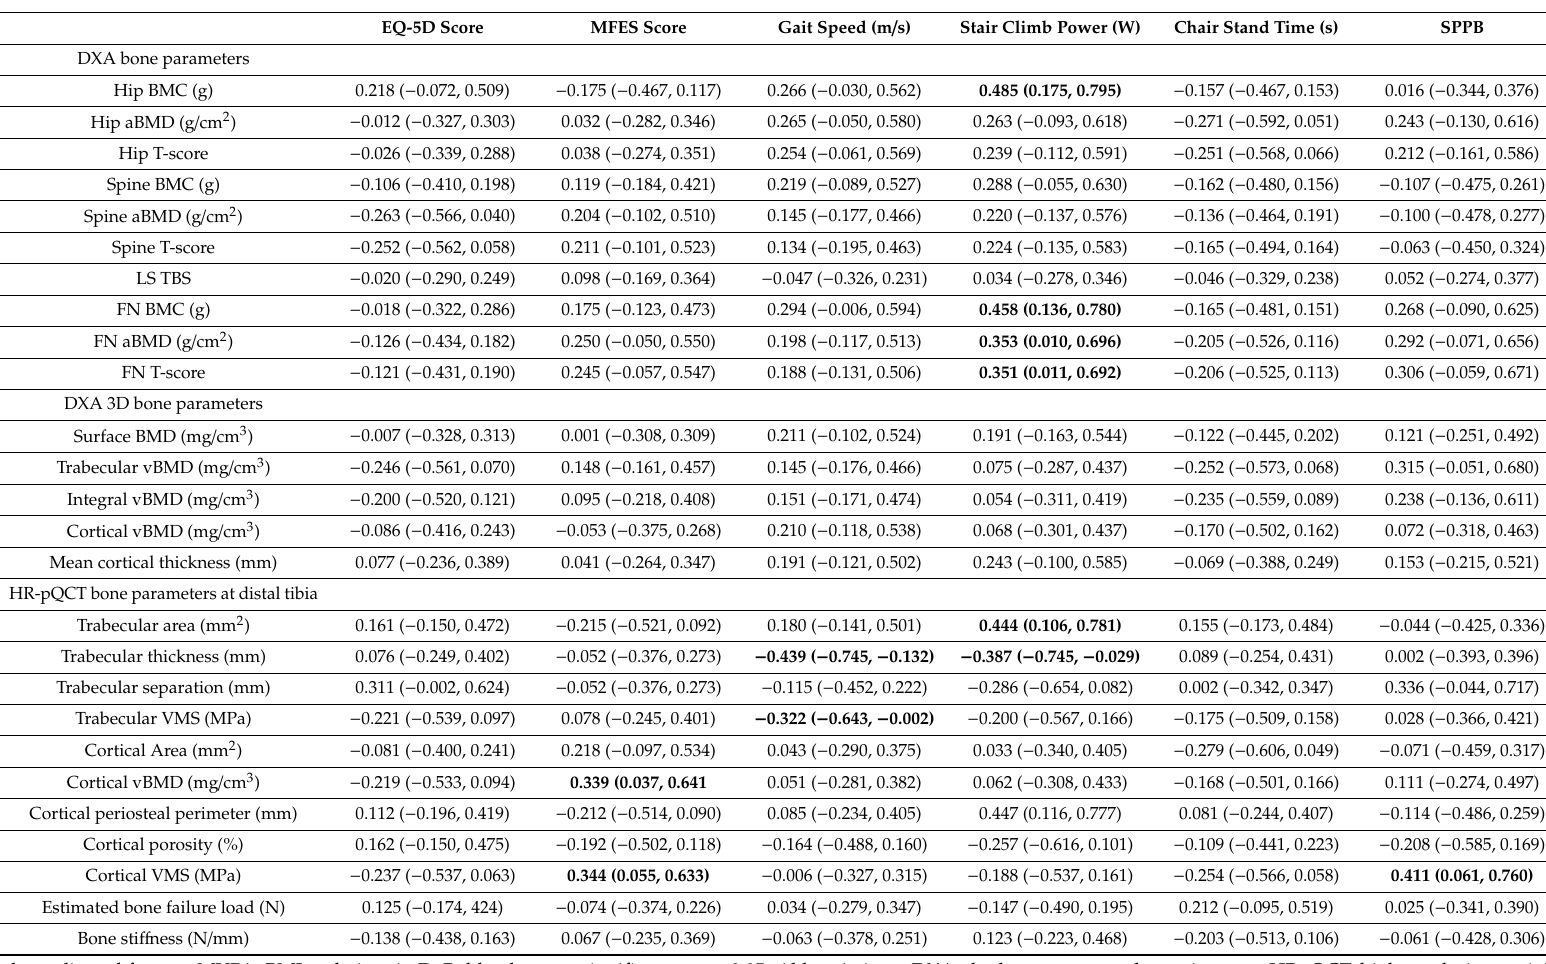
Table 4. Multivariable linear regression analysis examining associations between self-reported, objective measurements, and bone